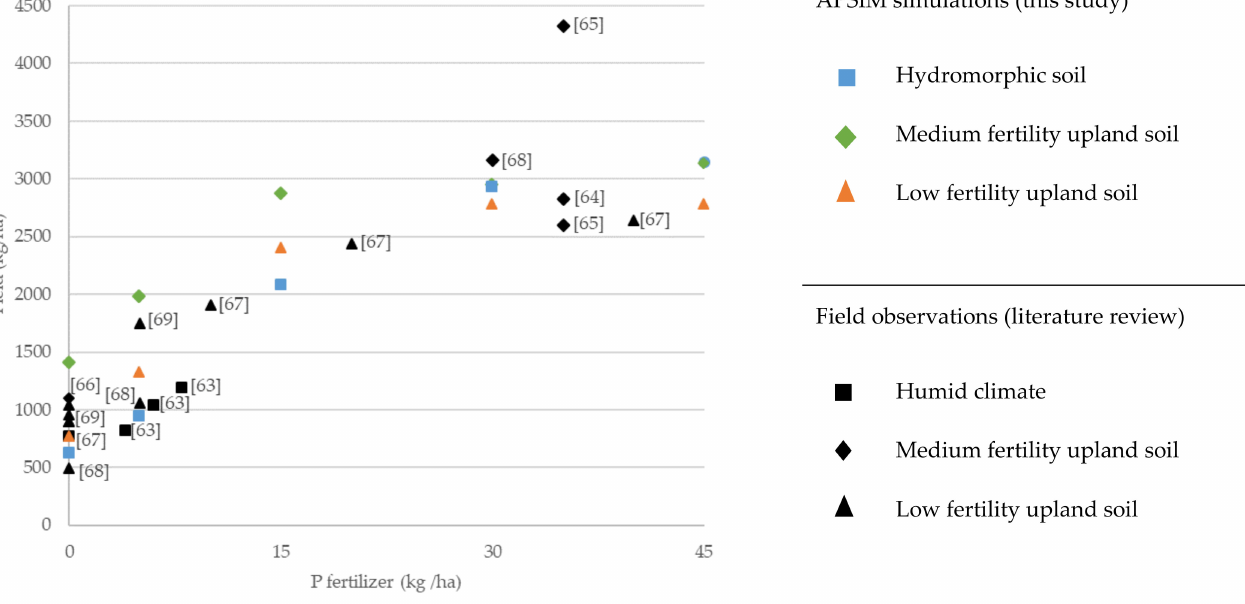
Figure 3. Groundnut simulated vs. published observed grain yields per fertilizer input level and soil fertility class. Numbers within brackets [] ([63–69]) indicate the reference of the publication from which data was